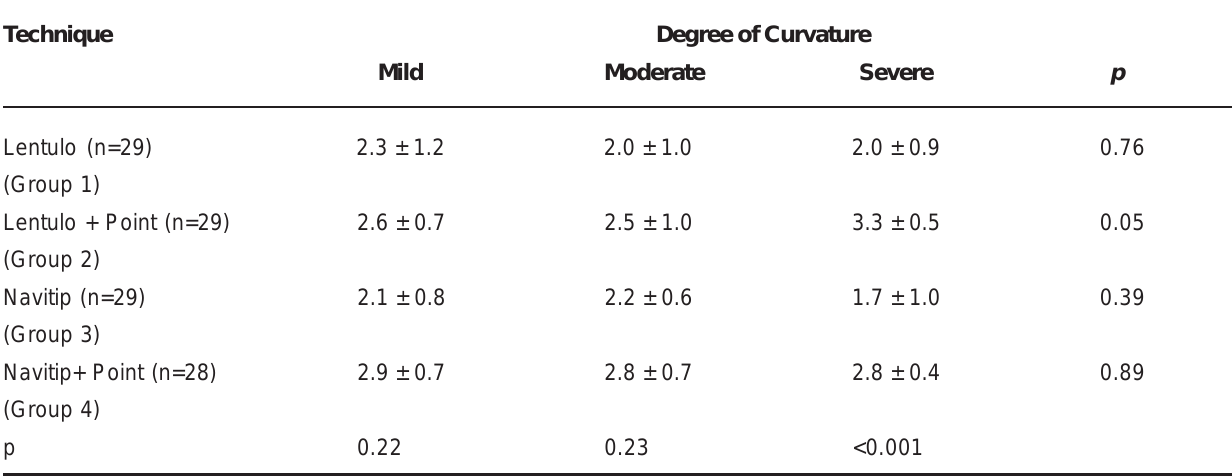
p = Statistical significance by analysis of